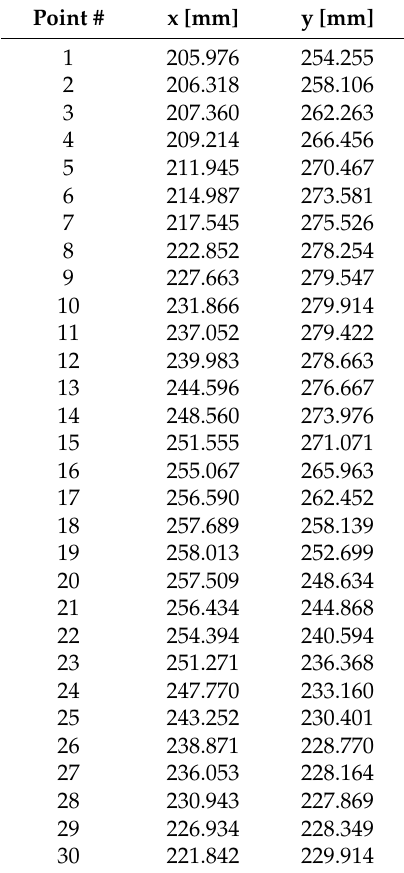
Table A3. Hemisphere datasets. (a) Plane Z